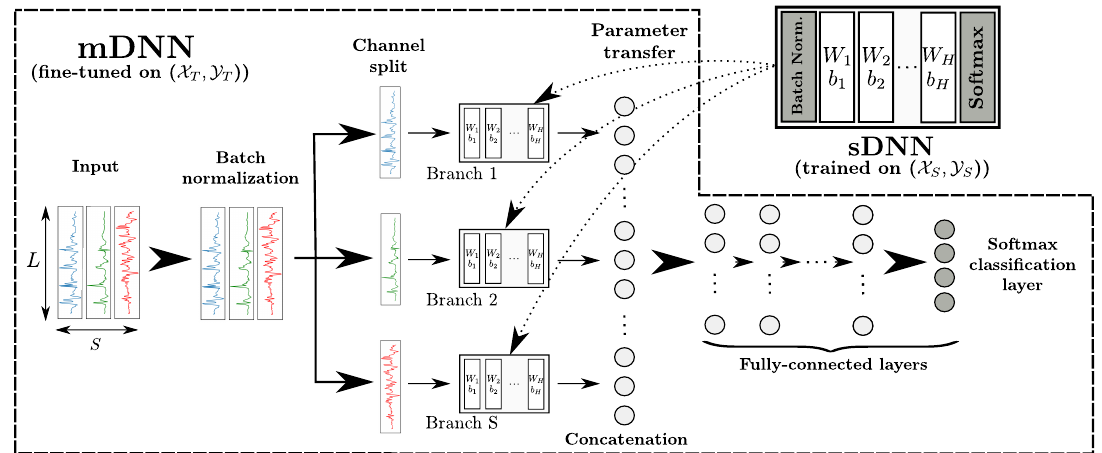
Figure 2. mDNN used for the learning of f T on the target domain. The input segments of the target dataset X T are sent through a batch normalisation layer. All sensor channels are then separated and processed by S branches with the same number and type of hidden layers as the sDNN trained on the source dataset ( X S , Y S ) . The outputs of the S branches are concatenated and sent through fully-connected and softmax layers for classification. The mDNN is fine-tuned using the target dataset ( X T , Y T )